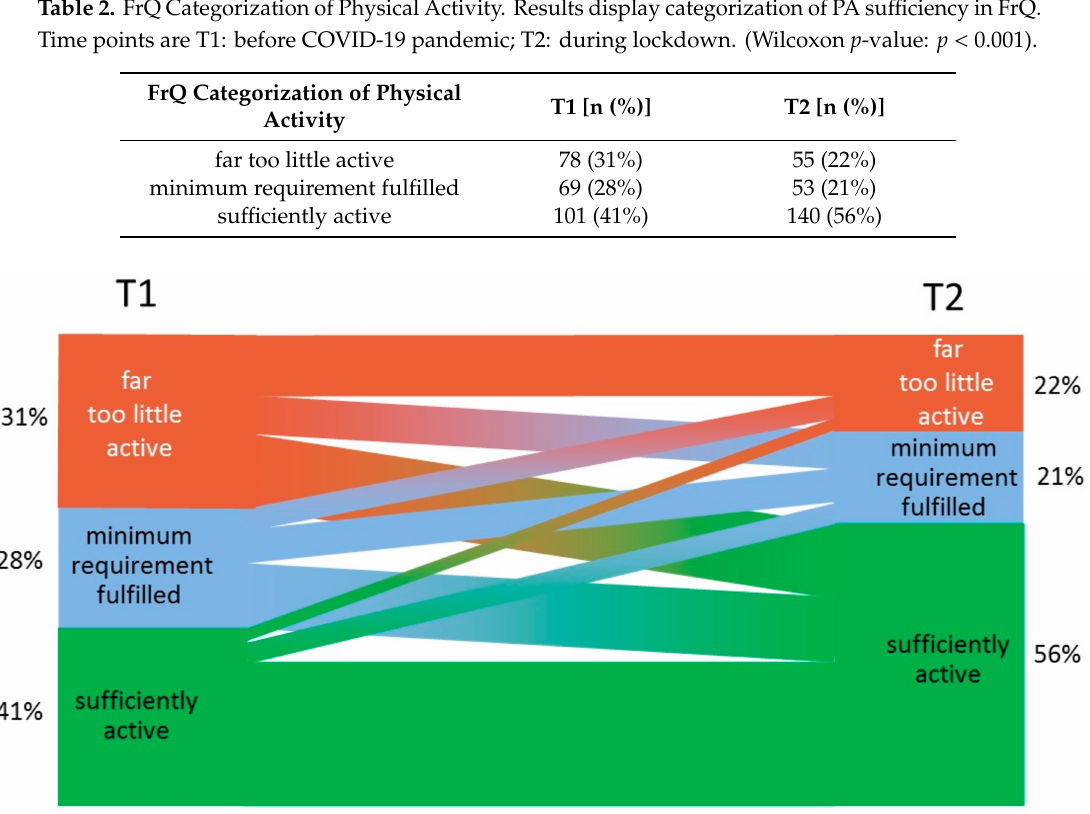
Figure 1. Sankey Plot of PA categorization changes in the Freiburg Questionnaire of Physical Activity. T1 described categorization before COVID-19 pandemic, while T2 describes PA during the